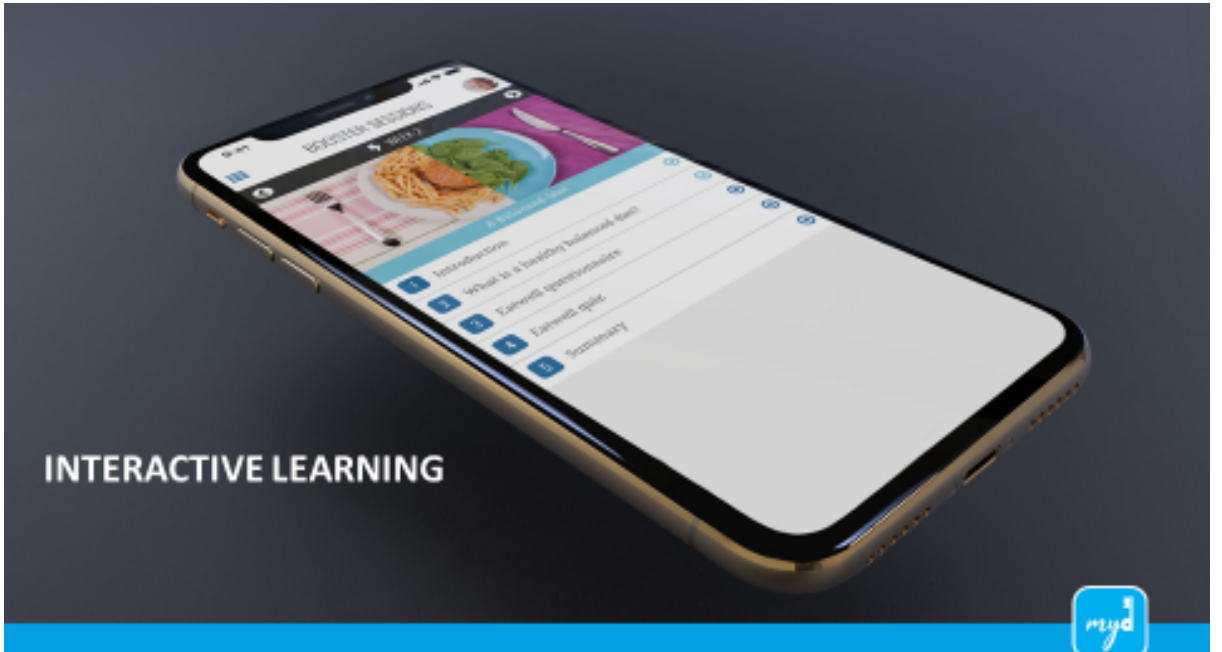
Figure 4. Users can learn about T2D and self-management activities and refresh knowledge with 8-weekly additional sessions (educational material, interactive quiz, animations) on